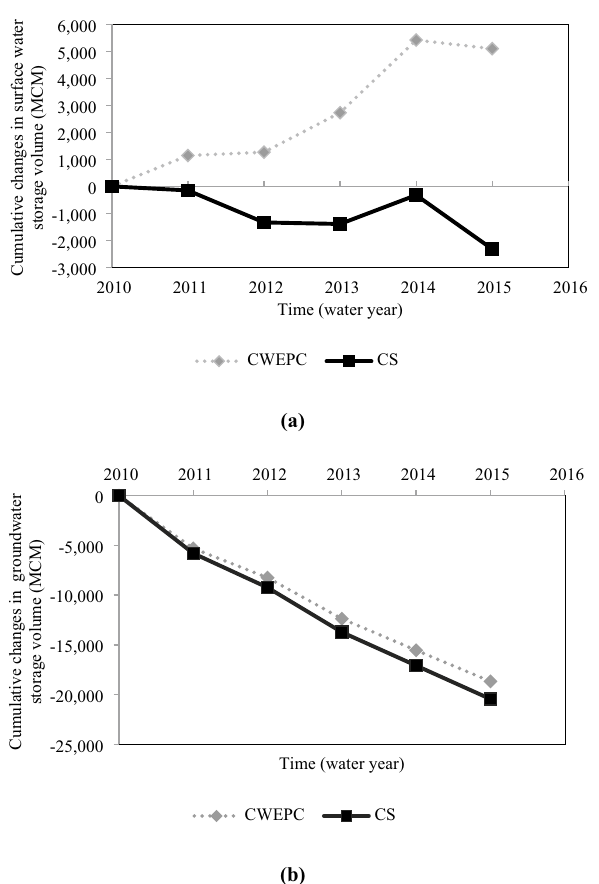
Figure 8. Changes in the cumulative volume of water resources ( a ) Surface water, and ( b ) Groundwater after water and energy per capita reductions are implemented ( CS current situation, and CWEPC changed per capita water and energy uses). MCM = 10 6 m 3